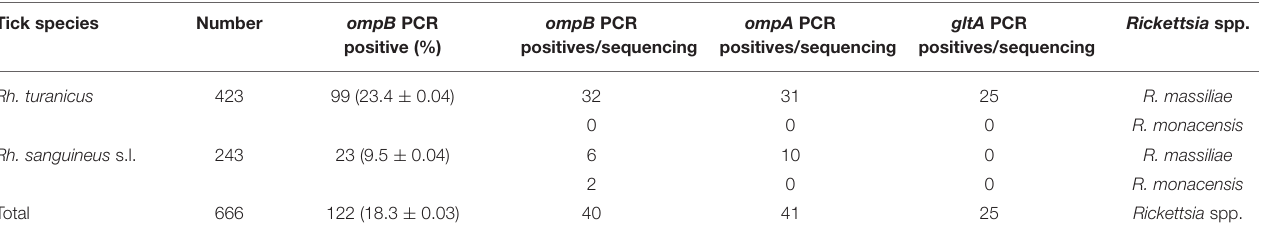
TABLE 3 | Rickettsia species identified by the sequencing of ompB , ompA , and gltA partial sequences in Rhipicephalus ticks. Tick species Number ompB PCR